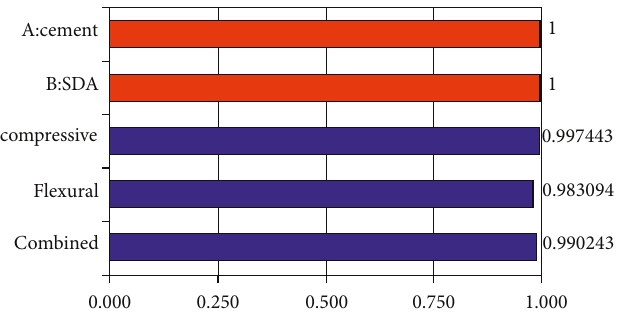
Figure 17: Bar graph for the desirability function.